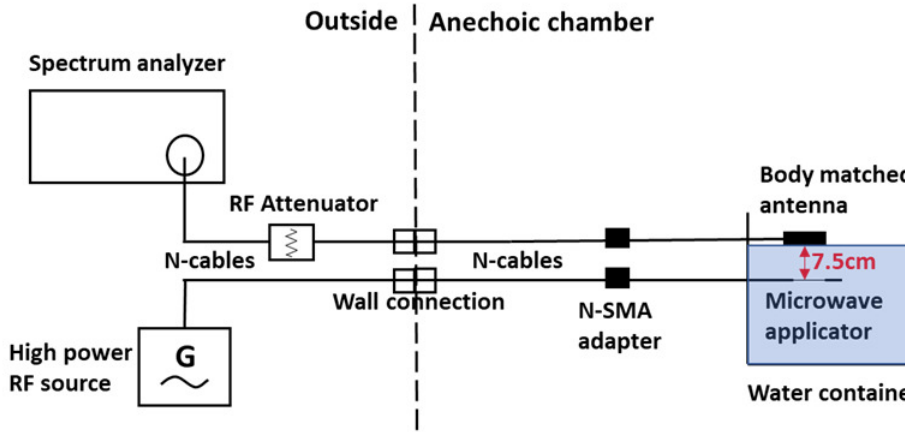
Figure 4. MWA experimental setup testing in water.